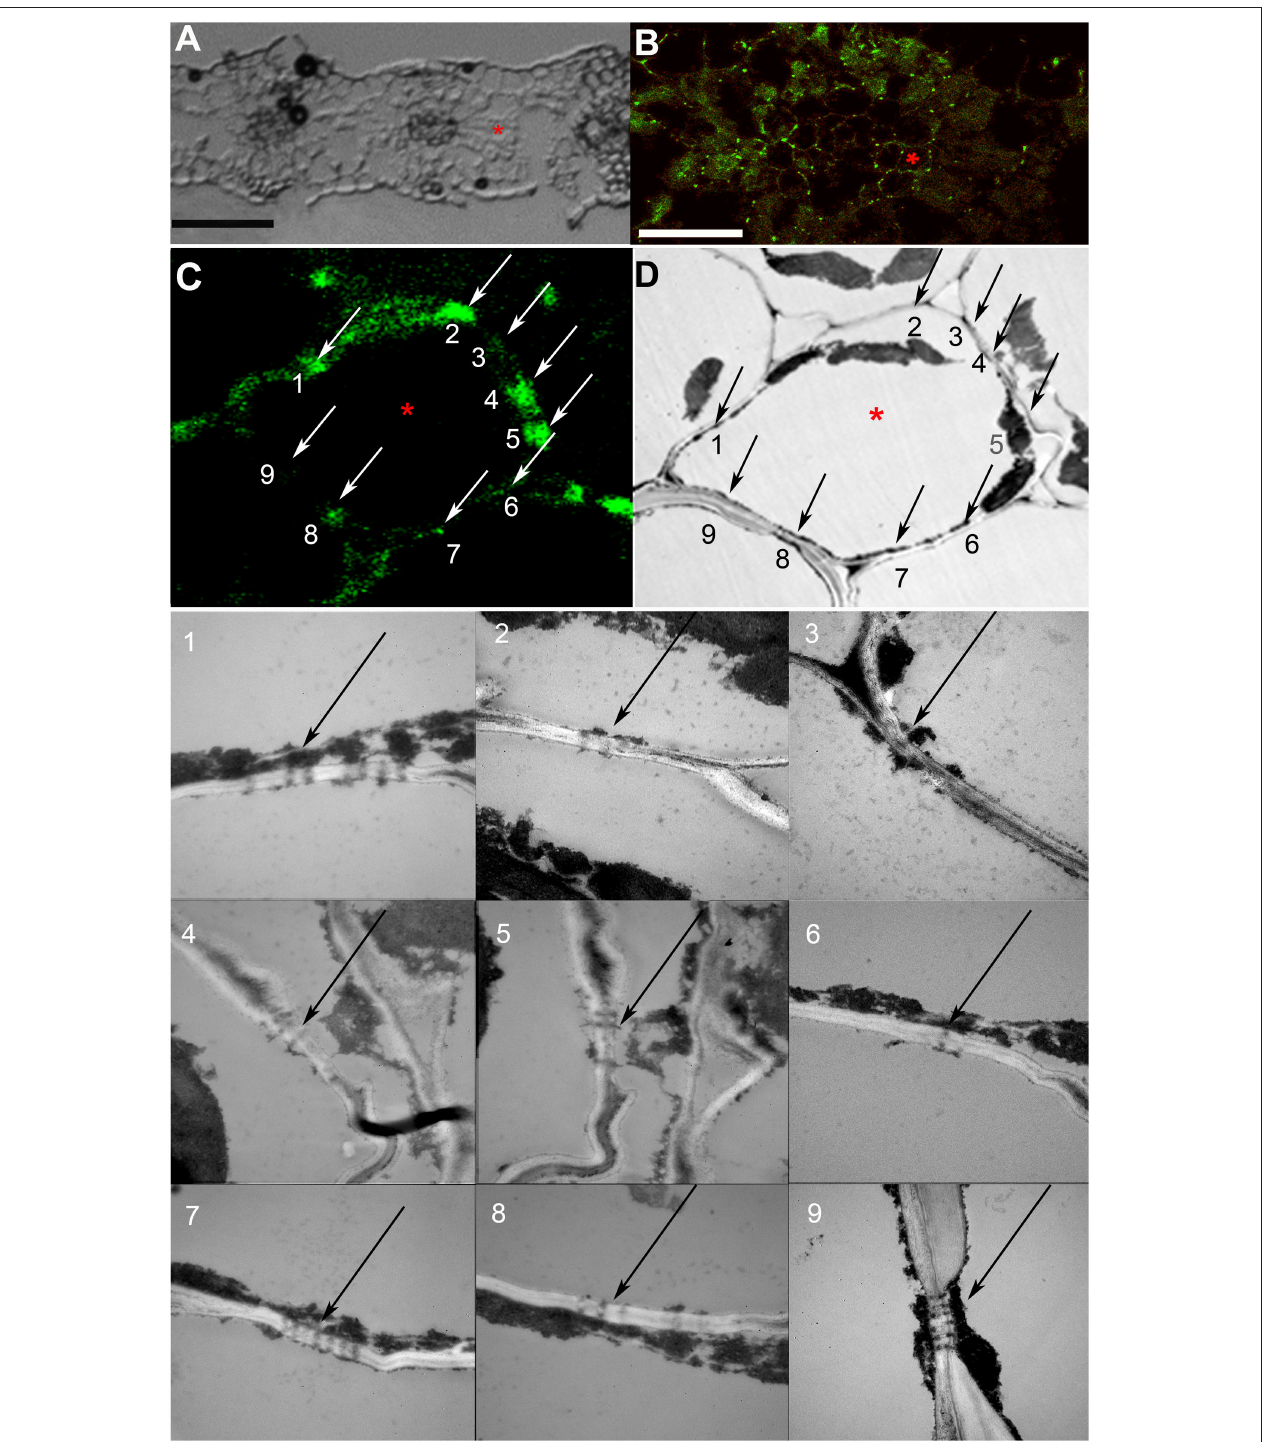
FIGURE 2 | Co-localization study of immunolabeled calreticulin and of plasmodesmata (PD). (A) A section of a barley leaf, an asterisk marks a mesophyll cell selected for further analysis. (B) A single confocal laser scanning microscopy (CLSM) image of the same section, the asterisk marks the same cell as in (A) . (C,D) Immunolabeled punctate pattern in the cell walls (C) and TEM image (D) of the cell marked with asterisk in (A) and (B) . Numbered arrows (C,D) point at sites of the cell wall that were examined by TEM as shown in TEM images with the same numbering; black arrows point to PD and pitfields. Size bars: 50 µ m (A) , 30 µ m (B) .